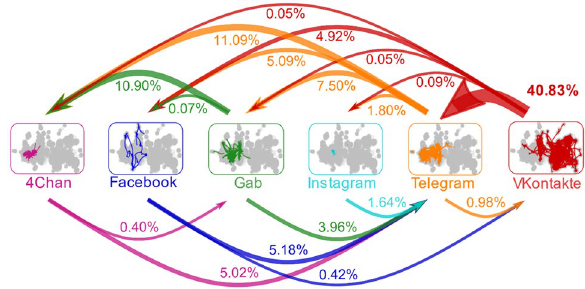
Figure 1. Connectivity of online hate multiverse. We counted all links between hate clusters on different social media platforms between June 1, 2019 and March 23, 2020. Each edge shows percentage of such links from hate clusters on the outbound platform to hate clusters on the inbound platform. Some platform pairs feature zero such links, hence no arrow. Although content moderation prevents users on some platforms (e.g., Facebook) from linking to some unmoderated platforms (e.g., 4Chan), users can access such content—and direct other users to it—by linking to a hate cluster on a third platform (e.g., Telegram) that then links to the unmoderated